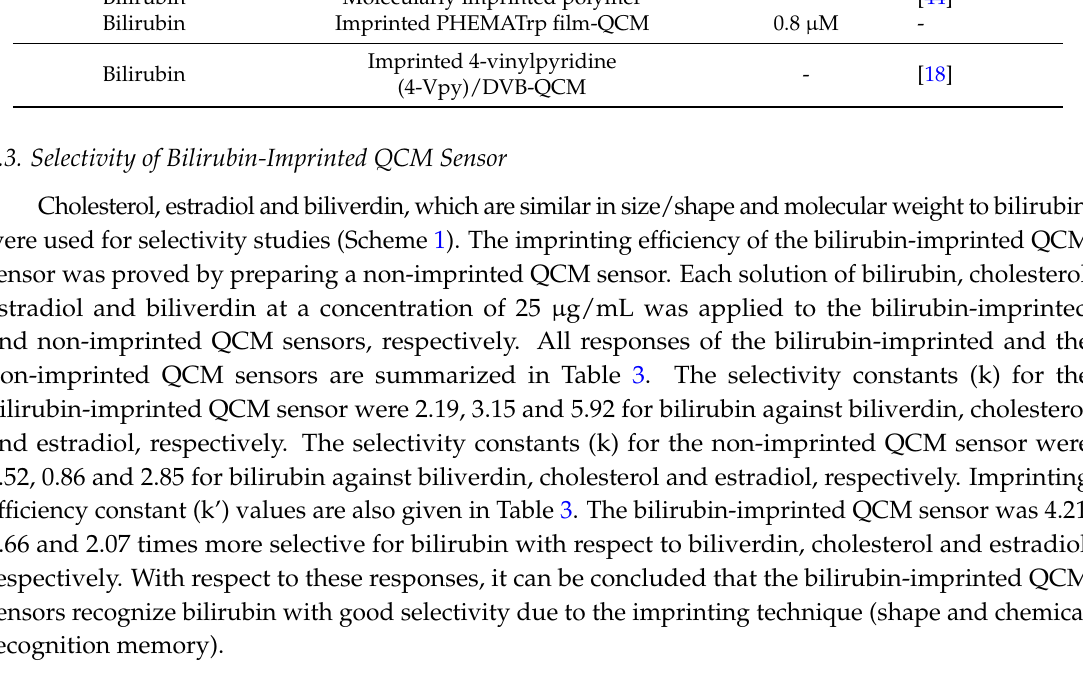
Table 2. Comparison of various bilirubin detection methods.